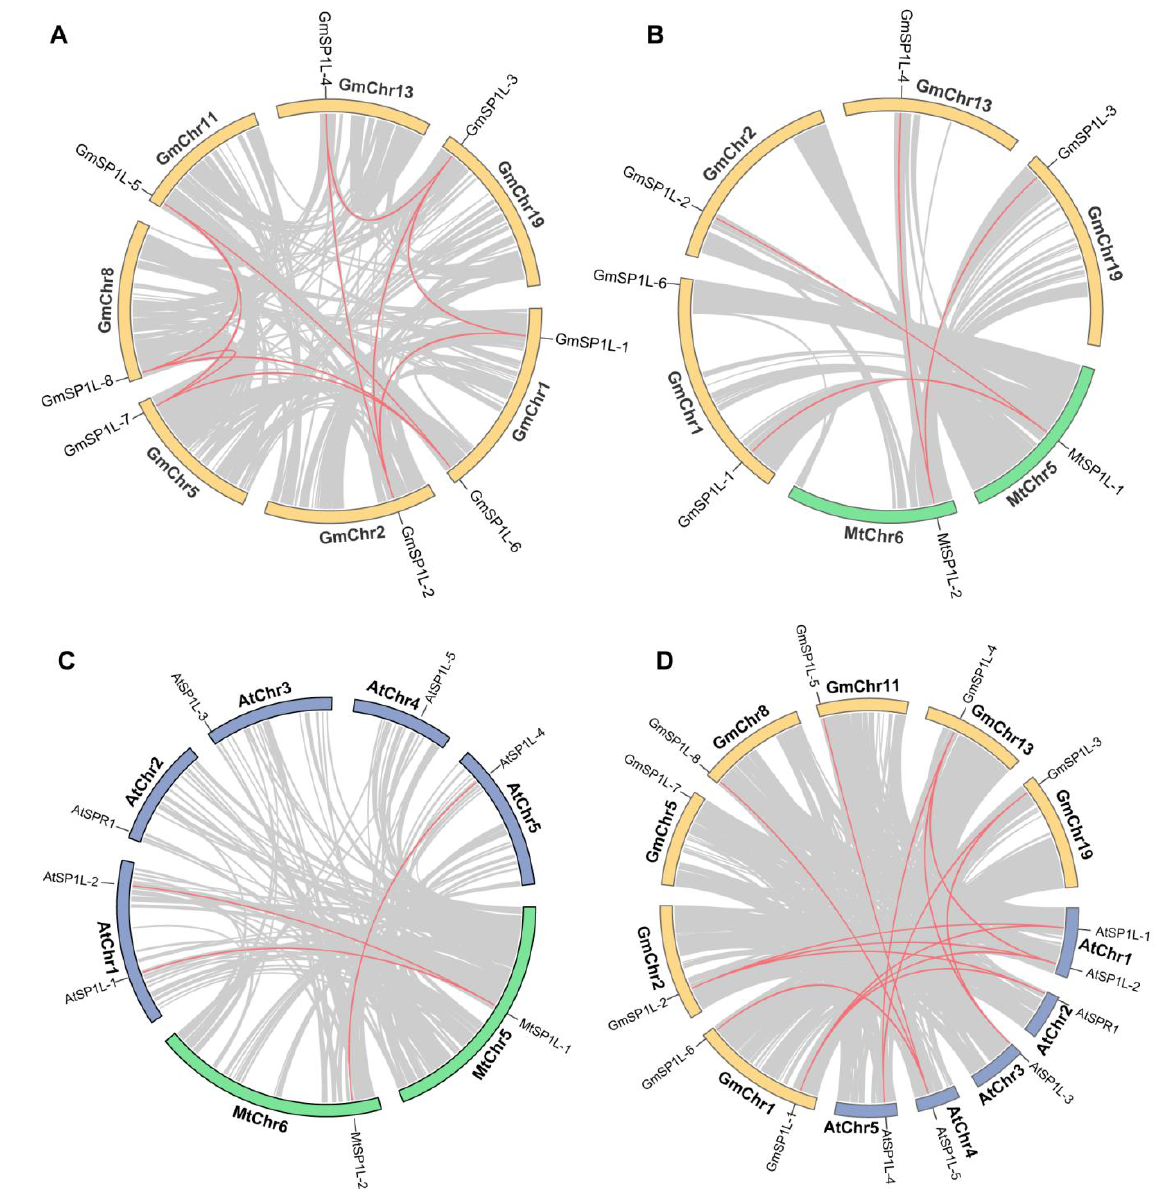
Figure 4. Chromosome distributions of the SP1Ls in M. truncatula and G. max . ( A ) The chromosomal location and interchromosomal relationship of the GmSP1Ls in G. max . The segmentally duplicated genes are connected by red lines. Synteny analysis of the SP1L genes between ( B ) M. truncatula and G. max ; ( C ) M. truncatula and A. thaliana ; and ( D ) G. max and A. thaliana. The gray lines in the background indicate the collinear blocks and the red lines highlight the syntenic SP1L gene pairs.